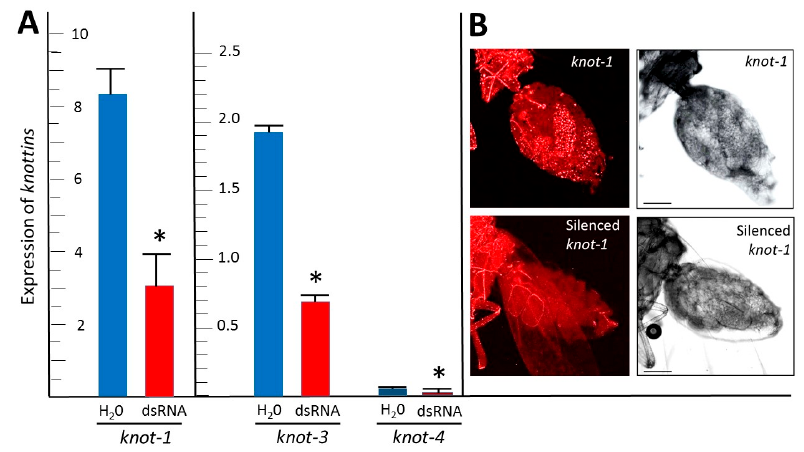
Figure 3. Expression of members of the whitefly Knottin gene family in insects: effect of gene silencing. ( A ) qPCR quantification of knot ‐ 1 ; ‐ 3 and ‐ 4 transcripts (relative to β‐ actin ) in adult whiteflies (collected 7 days after emergence) after caging the insects for 48 h with tomato leaflets bathing in water (H 2 O) or in knot ‐ 1 ; ‐ 3 and ‐ 4 dsRNA (dsRNA); ( n = 3; mean ± SEM). An asterisk above the bars indicates significant differences between treatments at p < 0.05. ( B ) Confocal microscopy (FISH) of knot ‐ 1 transcripts in the abdomen of female whiteflies; before (upper panels) and after (lower panels) knot ‐ 1 silencing; using a Cy3 ‐ labeled knot ‐ 1 primer. Left picture: bright field; right picture: red signal associated with the presence of knot ‐ 1 transcripts. Bar: 100 μ m.